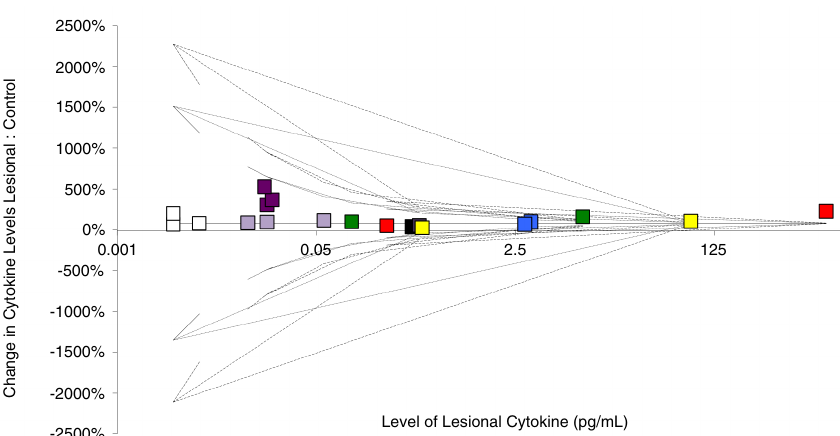
Figure 3. Funnel plot of selected cytokine in lesional and control samples of hidradenitis suppurativa. IL-1a = Red, IL-10 = Blue, IL-12p70 = Green, hBD1 = Purple, hBD2 = light purple, hBD3 = Black, S100A9 = White, GMCSF =